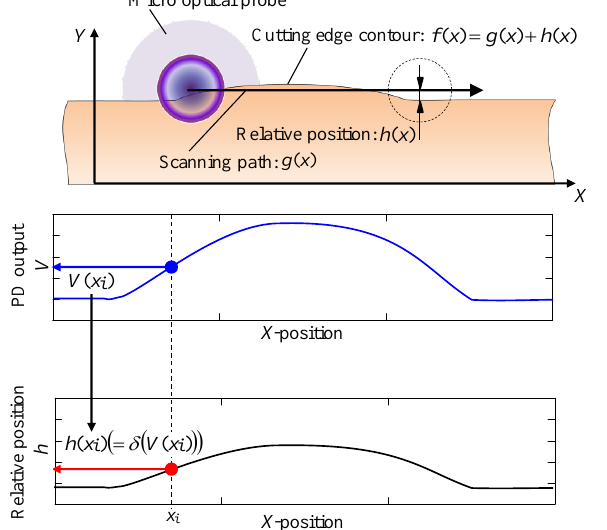
Figure 2. A schematic of how the PD output can be converted to the relative position of the probe with respect to the tool’s edge.